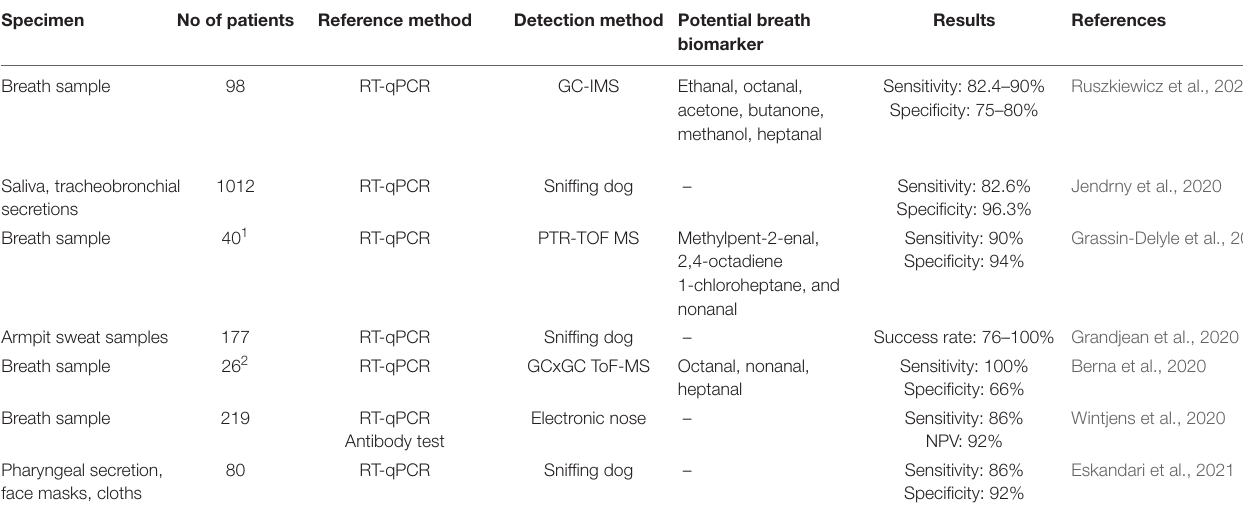
TABLE 1 | COVID-19 testing by analysis of volatile organic compounds